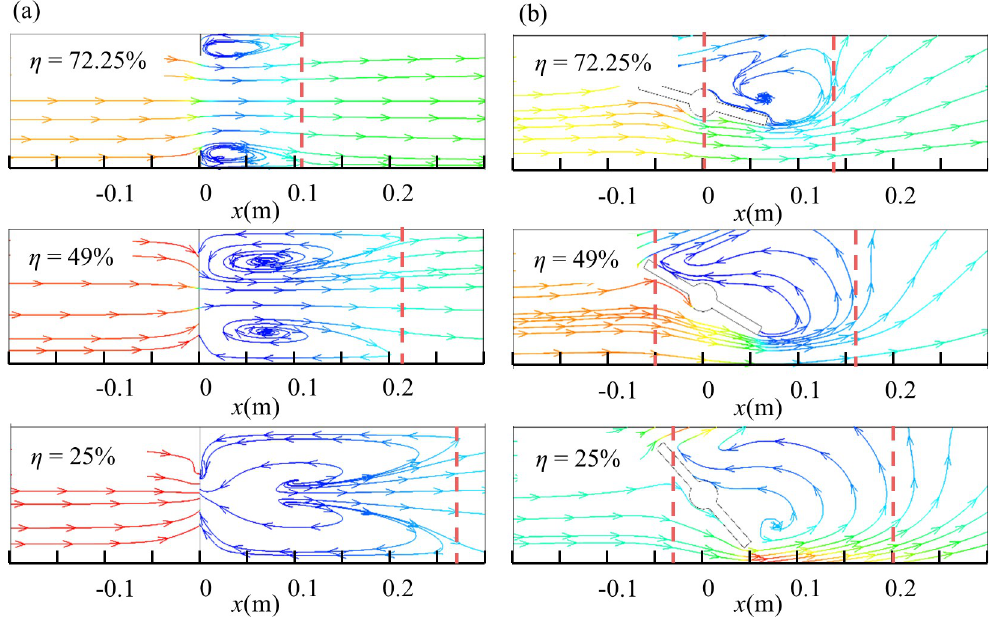
Fig 15. Streamlines distribution of x - z cross-section. (a) Air-ring flow regulating valve. (b) Center butterfly valve.